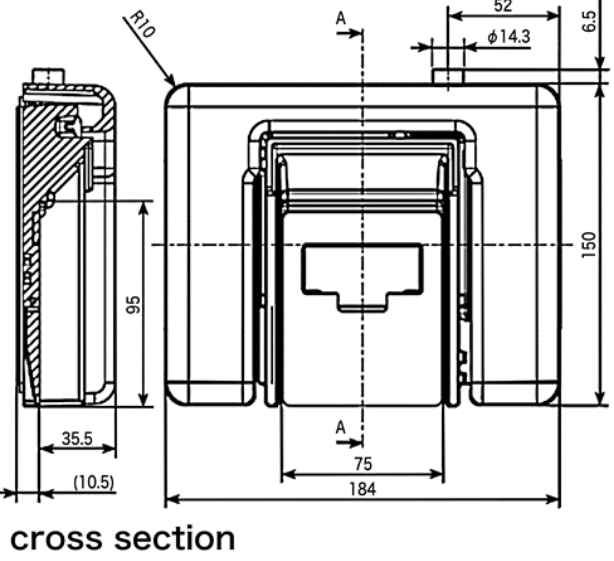
Figure 1. Sensor shape used in this paper. Figure courtesy of MinebeaMitsumi